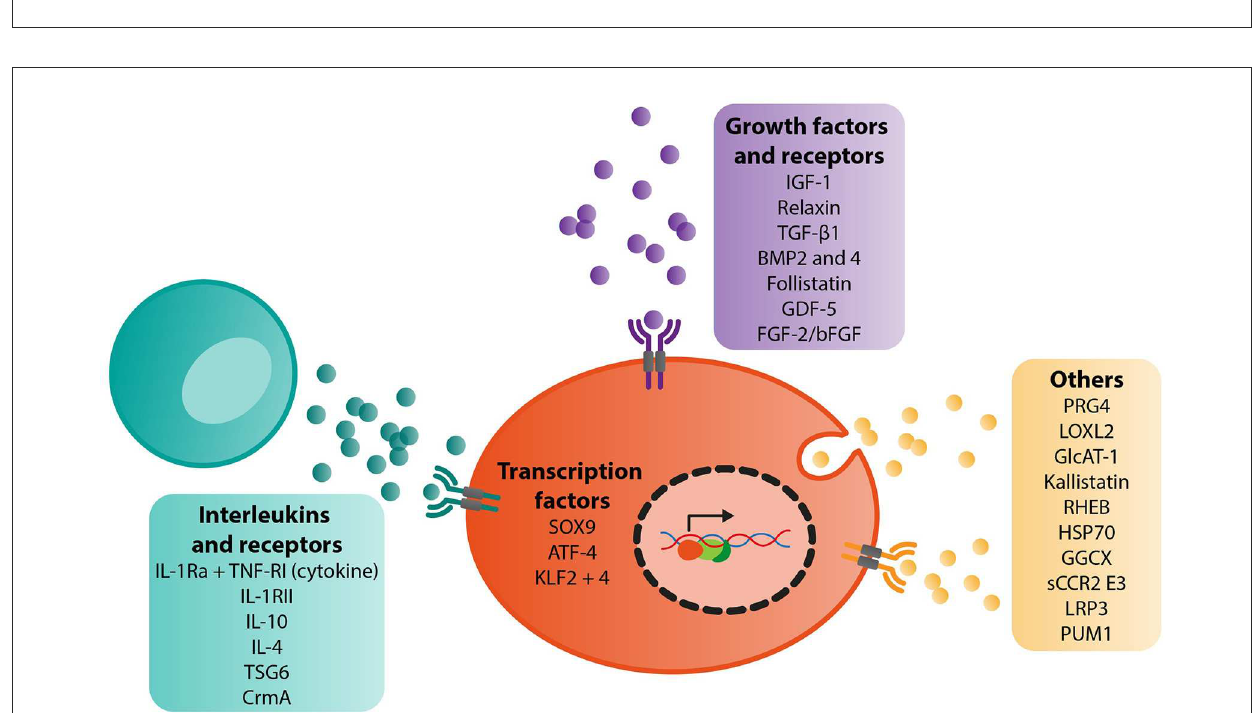
FIGURE2 Summary of target genes identified for gene therapy of OA and their biological